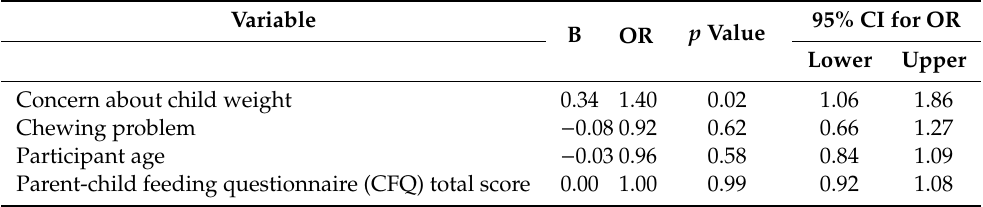
Table 11. Multivariate binary logistic regression for prediction of BMI in the participants. Variable